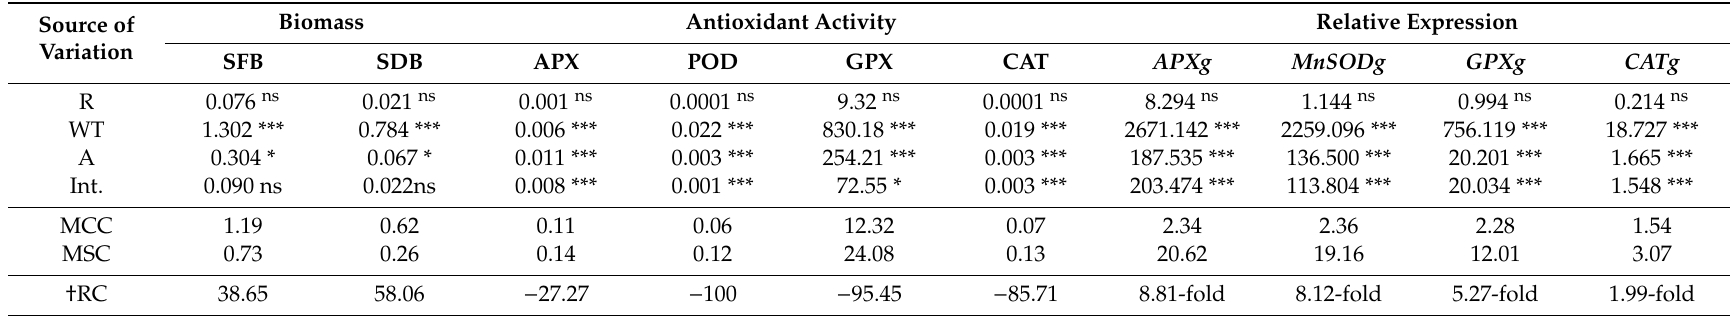
Table 2. Analysis of variance, mean values, and relative change in biomasses, antioxidant enzyme activities, and antioxidant enzyme-encoding gene expressions in the four investigated wheat